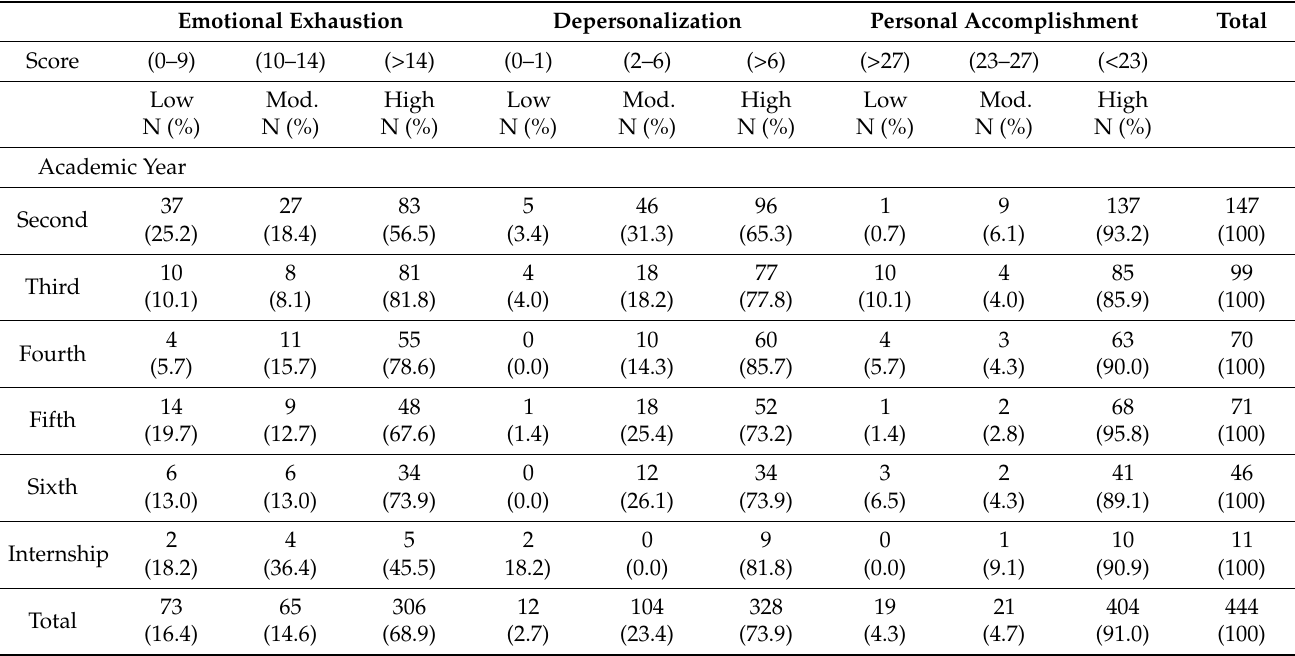
Table 2. The prevalence of burnout syndrome three subscales according to the academic year among medical students (N =